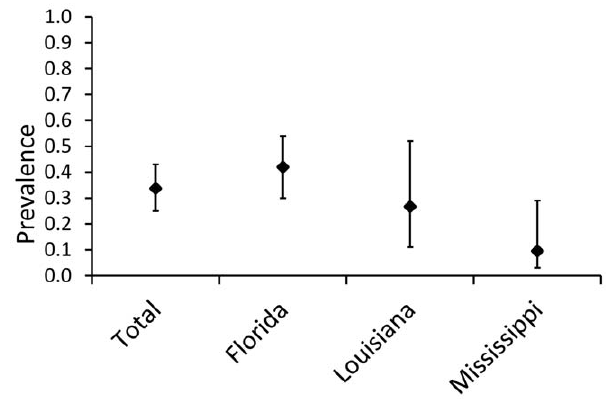
Figure 3. Prevalence of Bd infection in all sampling localities combined (Total, N=98), Florida (N=62), Louisiana (N=15), and Mississippi (N=21). Bars indicate 95% confidence interval.